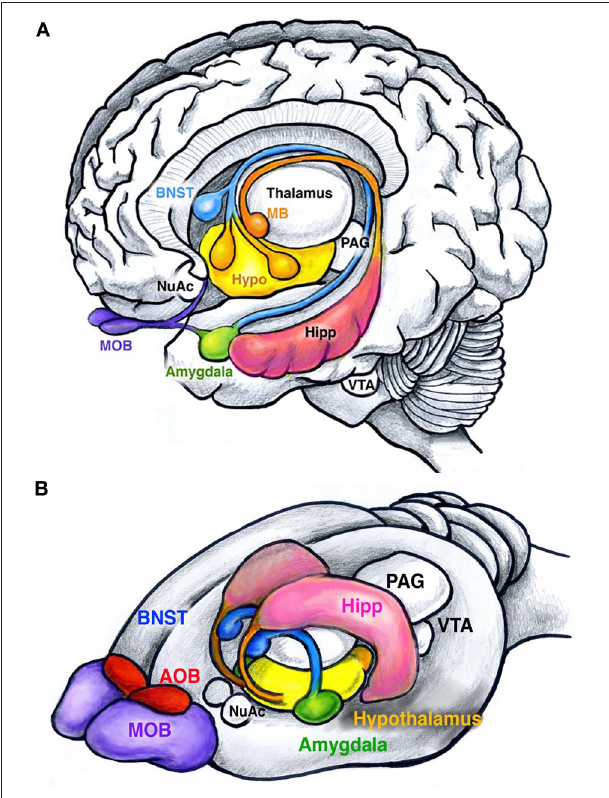
FIGURE 1 | Main structures of the human and rodent limbic system. (A) Human brain showing the amygdala (green), bed nucleus of stria terminalis (BNST, blue), hypothalamus (yellow), and hippocampus (pink). The hippocampus (pink) attaches to the mamillary bodies (orange) through the fimbria-fornix. Olfactory inputs are received by the olfactory bulbs (MOB, purple). Other structures include the nucleus accumbens (NuAc), ventral tegmental area (VTA), and the periaqueductal gray (PAG). (B) Similar structures are found in rodents. Note the enlarged olfactory bulbs compared to humans, and the presence of the accessory olfactory bulbs (AOB, red). Together these structures facilitate the execution and reinforcement of innate